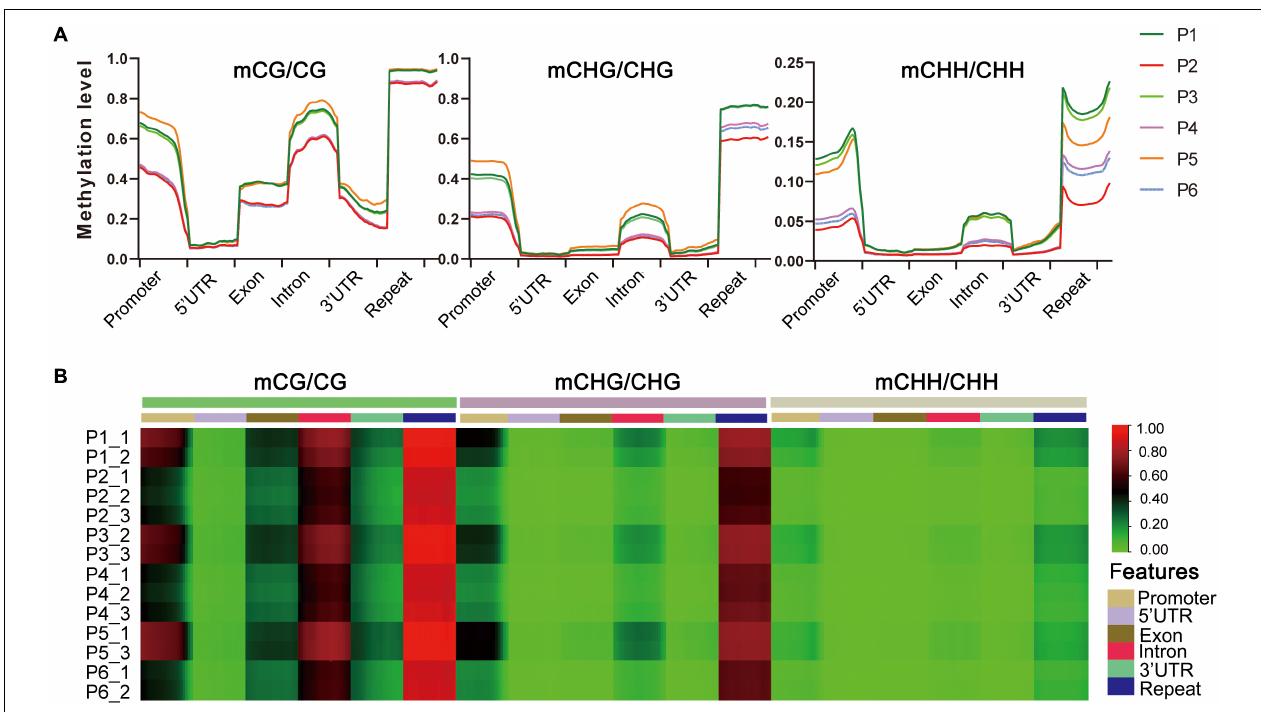
FIGURE 3 | DNA methylation levels in different genomic regions of F. nilgerrensis . (A) Distribution of DNA methylation among gene component and repeats. (B) Heat map of methylation levels of promoter, repeat, coding genes with 5 (cid:48) UTR, exon, intron, and 3 (cid:48) UTR in each